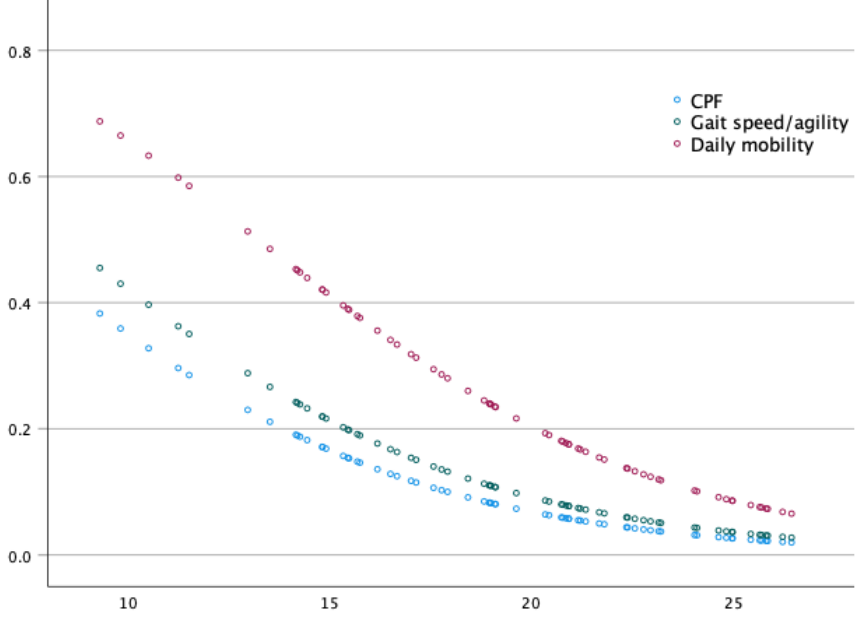
Figure 1. Chance of low physical functioning estimated from a questionnaire (CPF), physical perfor- mance (gait speed/agility), or daily mobility (steps/day) according to vertical jump power (W/kg).